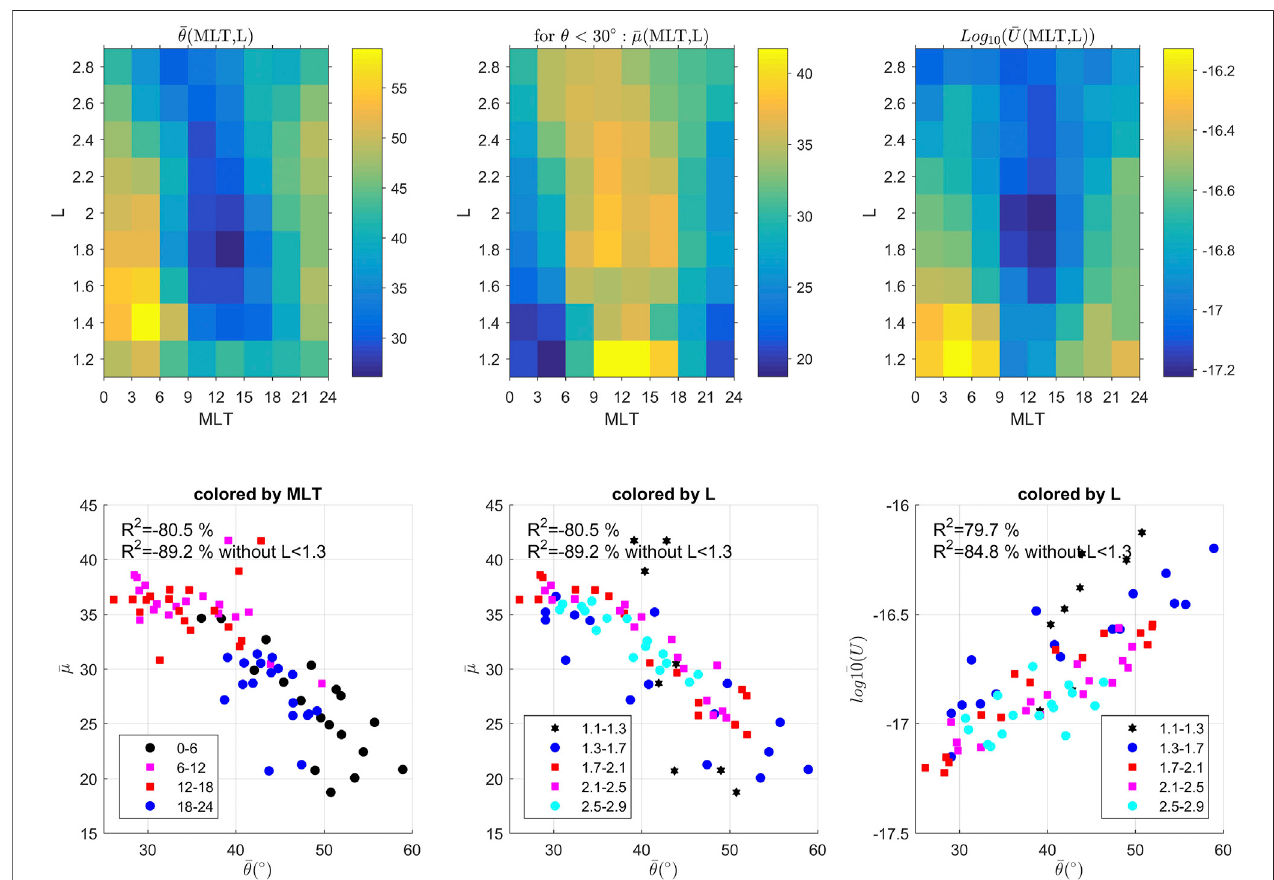
FIGURE 11 | (top, left) Wave normal angle ( θ ), (top, center) refractive index (µ), and (top, right) wave energy density (U) binned by (MLT, L) (bottom) refractive index as a function of wave normal angle (for a given (MLT, L) bin colored by (left) MLT and (center) L-shell. Dark colors (blue and black) are used for night sectors and low L-shells. There is a high anti-correlation (-80%) between µ and θ , with small wave normal angle at large refractive index and vise-versa. The peak of distribution of electromagnetic waves withboth large/low magnetic/electric amplitudes will fall inthe upper left corner. The peak ofdistribution ofelectrostatic waveswillfall in the lower right corner (bottom, right) LGW energy density as a function of wave normal angle for a given (MLT, L) bin colored by L-shell. There is a high correlation (-80%) between U and θ , with small wave normal angle at low energy density and